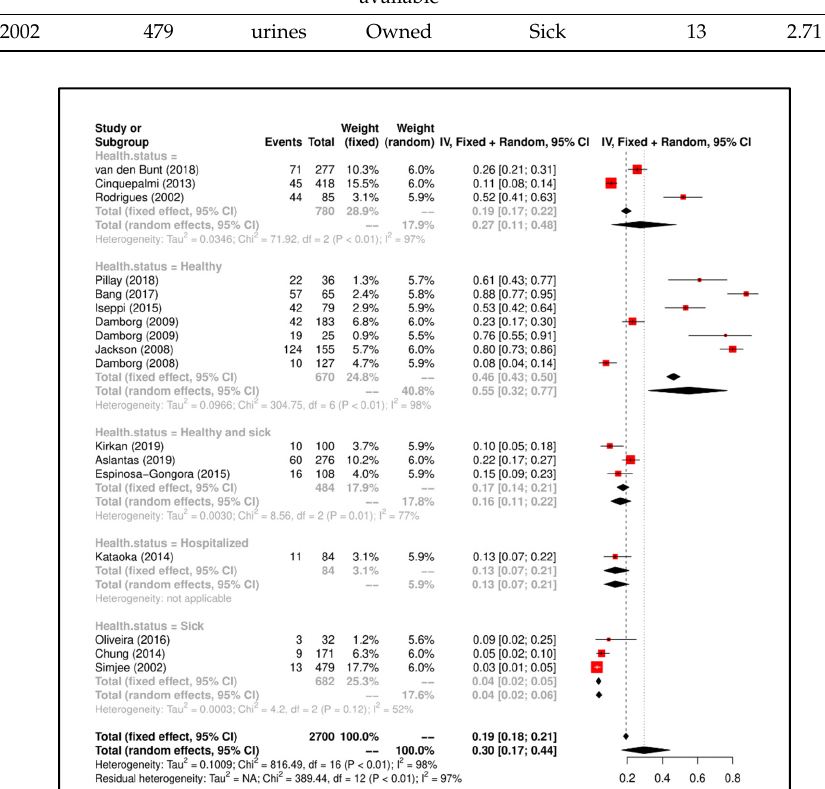
Figure 2. Forrest plot corresponding to occurrences of the E. faecium grouped by “health status of